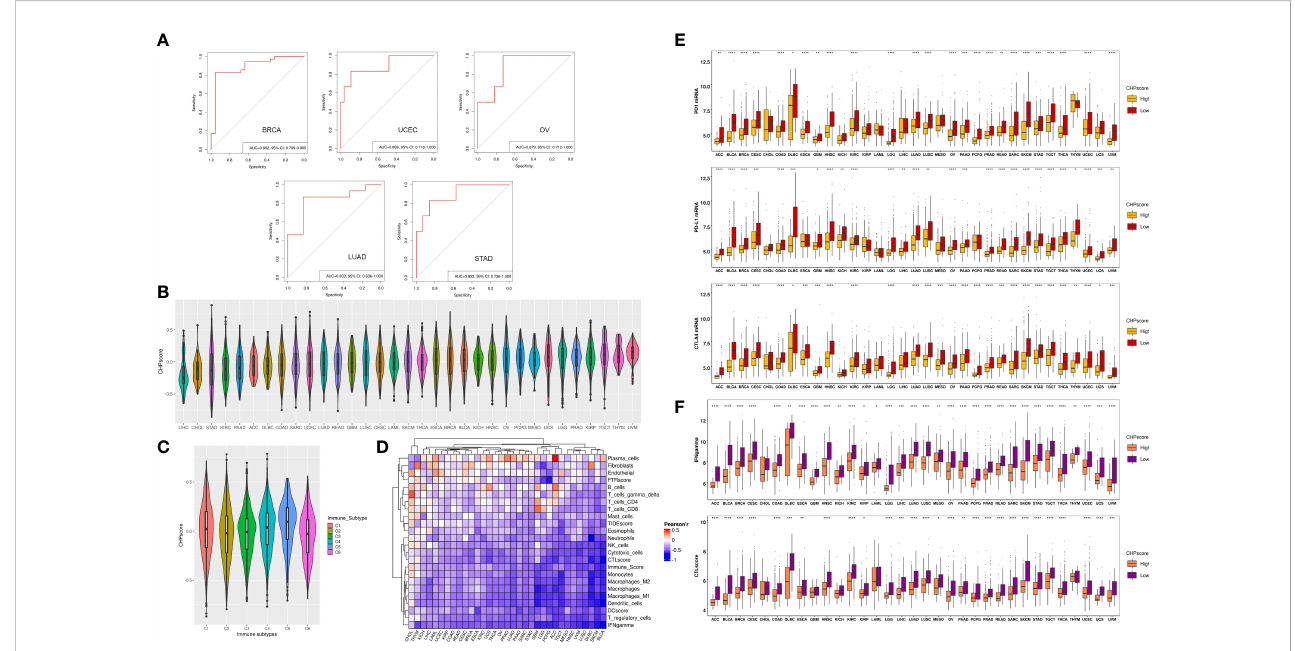
FIGURE 2 The construction of CHP score and the link with tumor immune evasion. (A) ROC curve indicates the ability of the CHP score to predict the occurrence of chromothripsis in fi ve types of cancer. (B) The CHP score in all 33 types of cancer in the TCGA database. (C) The CHP score among all samples classi fi ed into C1, C2, C3, C4, and C5 groups. (D) The Pearson correlation coef fi cients of CHP score with the abundance of different immune cells and the immune signature in 33 types of cancer in TCGA database. (E) The expression of immune check-point factors in CHP score high and CHP score low groups. (F) Immune signature gene expression in CHP score high and CHP score low groups. *p < 0.05, **p < 0.01, ***p < 0.001, **** p <